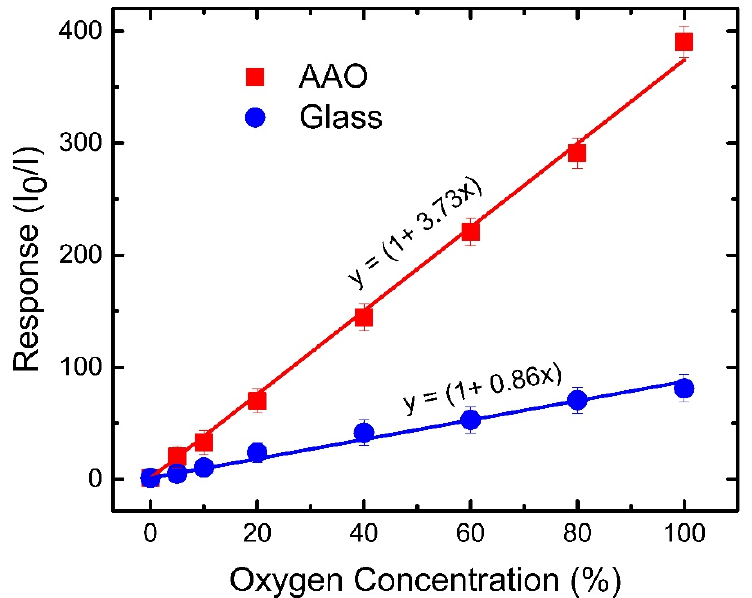
Figure 6. Responses as functions of oxygen concentrations for PtTFPP-based oxygen sensors by using AAO membranes (red squares) and glass substrates (blue dots). Equation (1) is used to fit the data points as shown by red (AAO case) and blue (glass case) lines. Y-axis error bars represent the standard deviations of the data from 10 samples.